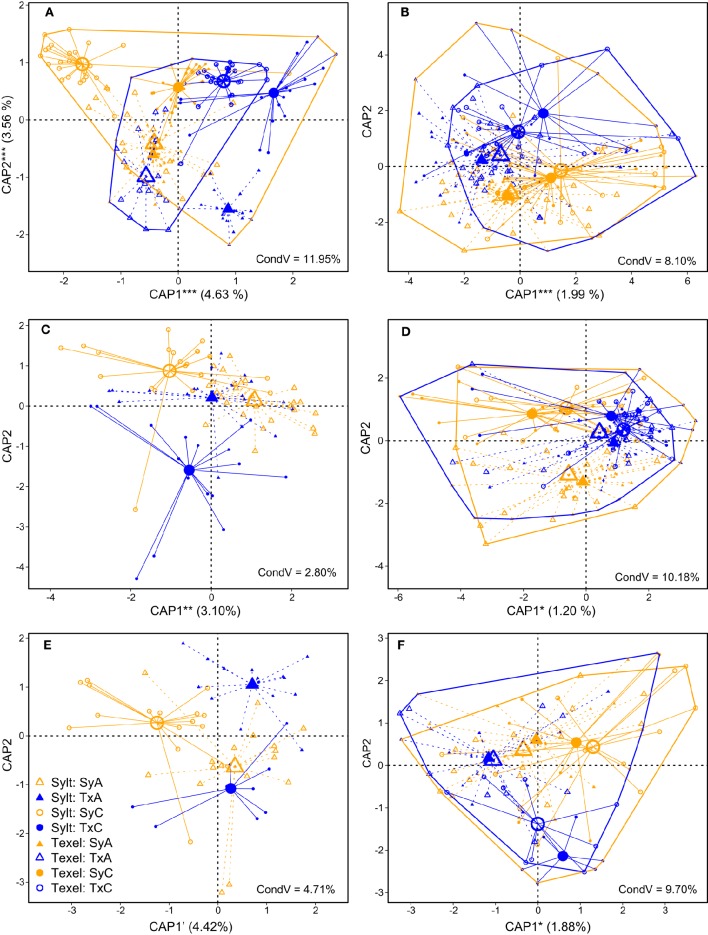
Constrained analysis of principal coordinates (CAP) of β-diversity of hemolymph communities on Sylt and Texel showing the effects of oyster origin and antibiotic treatment after partialling out the effect of distance (variation explained by distance is given in the plots, “CondV”). (A) Pre-deployment, (B) June, (C) July Sylt only, (D) July, (E) August Sylt only, (F) August. The percentages in parentheses represent the variability explained by significant axes. ***p < 0.001, **p < 0.01, *p < 0.05, 'p < 0.1. Hulls enclose all samples from the same site (Sylt = orange, Texel = blue).